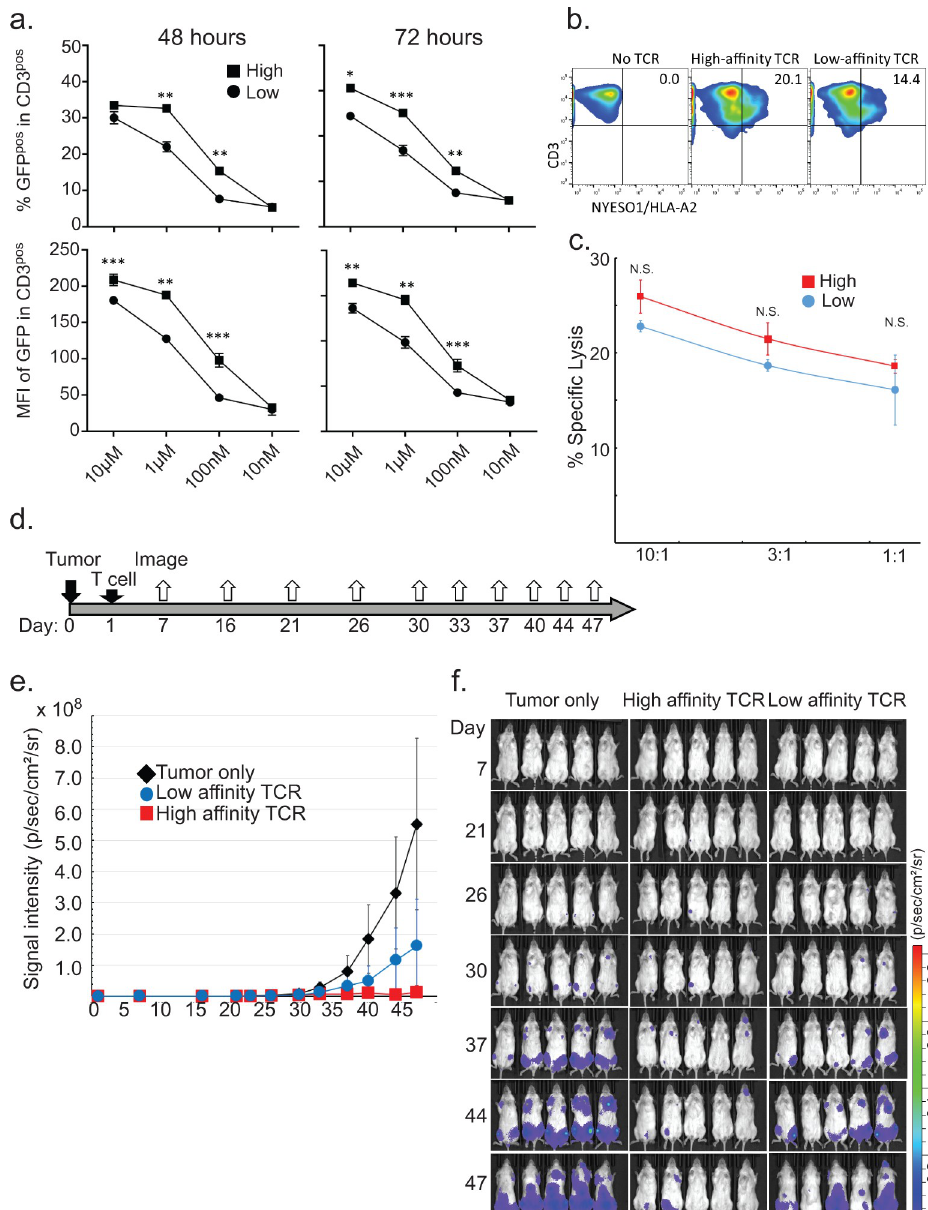
Fig 3. Comparison of high- and low-affinity NY-ESO-1/HLA-A2 − specific TCR. a. Our reporter assay revealed the GFP expression of each JRFTCR transduced with NY-ESO-1/HLA-A2 − specific TCR and then stimulated with HLA-A2 − transduced 721.221 cells pulsed with different amounts of the NY-ESO-1/HLA-A2 peptide (SLLMWITQV). The top panels show the percentages of CD3 + cells (cells expressing NY-ESO-1/HLA-A2 − specific TCR) with GFP expression. The bottom panels show the mean fluorescence intensity (MFI) of GFP in the CD3 + population. Error bars indicate standard deviations. � p < 0.01; �� p < 0.005; ��� p < 0.001. b. Multimer staining of T cells transfected with NY-ESO-1/HLA-A2 − specific TCR. The numbers represent the percentages of CD3 + cells expressing NY-ESO-1/ HLA-A2 − specific TCR. The data were acquired 2 days after electroporation. c. 51 Cr release assay revealed the activity of T cells transduced with NY-ESO-1/HLA-A2 − specific TCR against HLA-A2 + NY-ESO-1 + U266 cells. Error bars indicate standard deviations. N.S., not significant (p > 0.01). d. Timeline of the xenograft experiment. e. Luciferase- transduced U266 xenografts in NSG mice were monitored periodically using the Xenogen IVIS Spectrum system. f. Tumor xenografts in NSG mice.